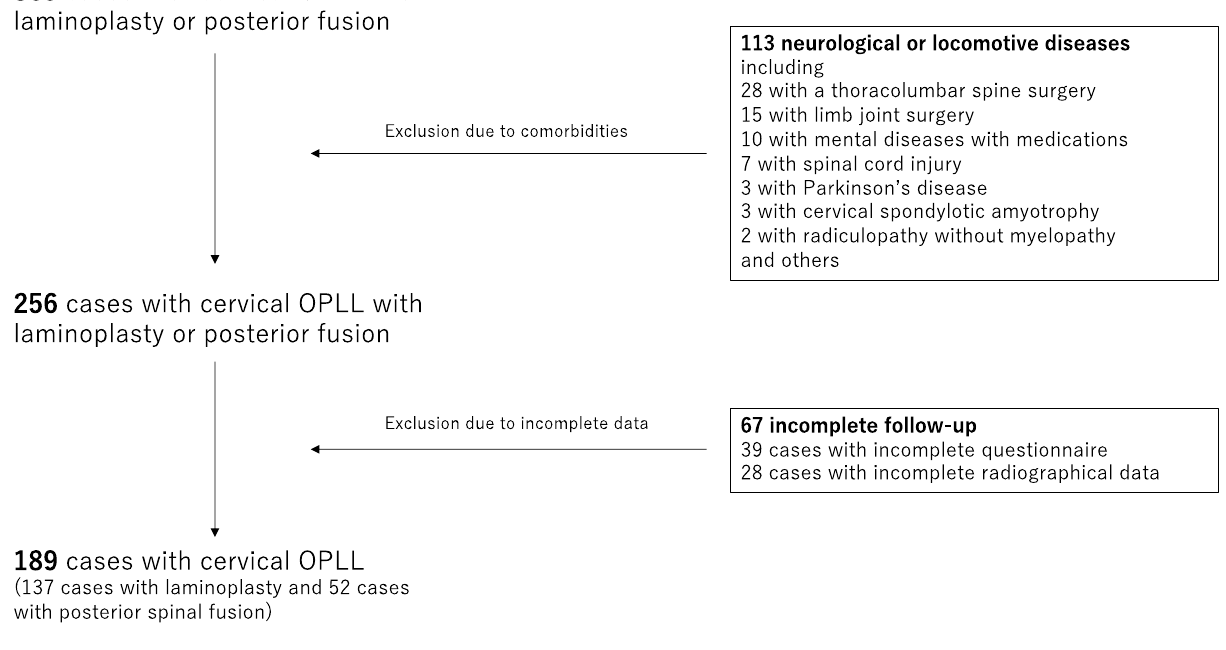
Figure 1. Patient selection